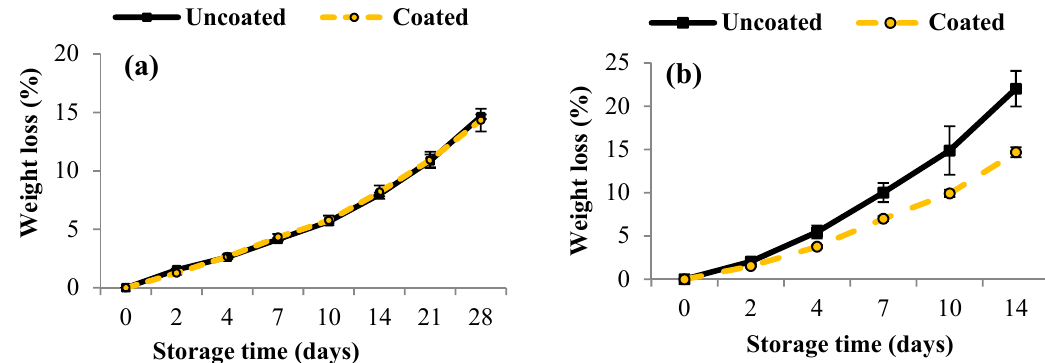
Figure 2. Weight loss of uncoated (C) and coated (P) blueberries storage at 4 °C for 28 days ( a ); and 16 °C for 14 days ( b ). Error bars represent the standard deviation. Values are means of three ( n = 3) replications.